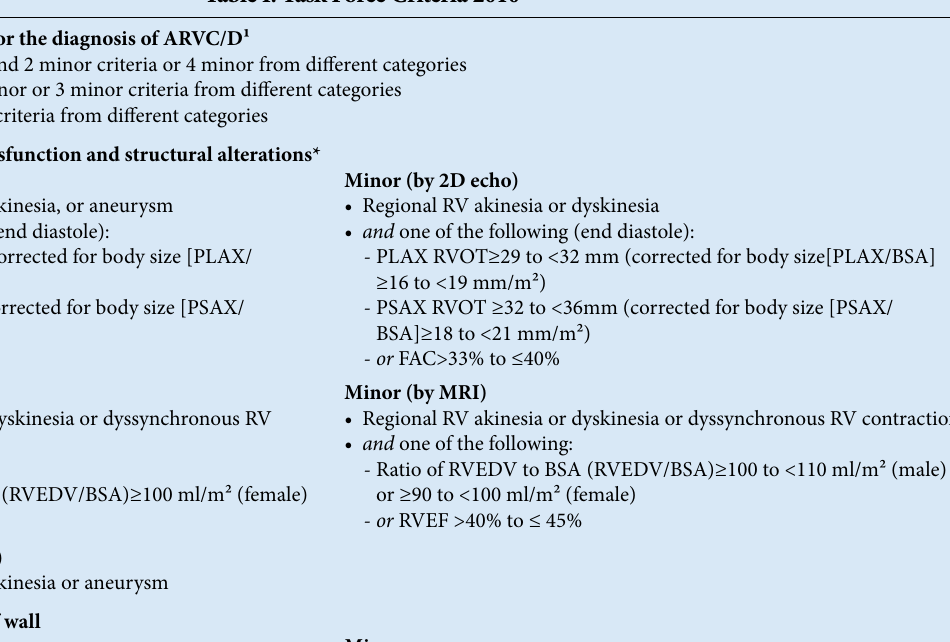
Table I. Task Force Criteria